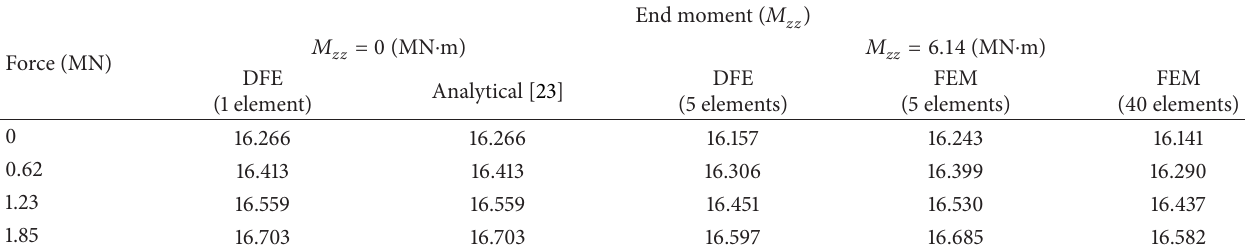
Table 2: DFE fundamental frequencies (Hz) for clamped-clamped (C-C) boundary condition.